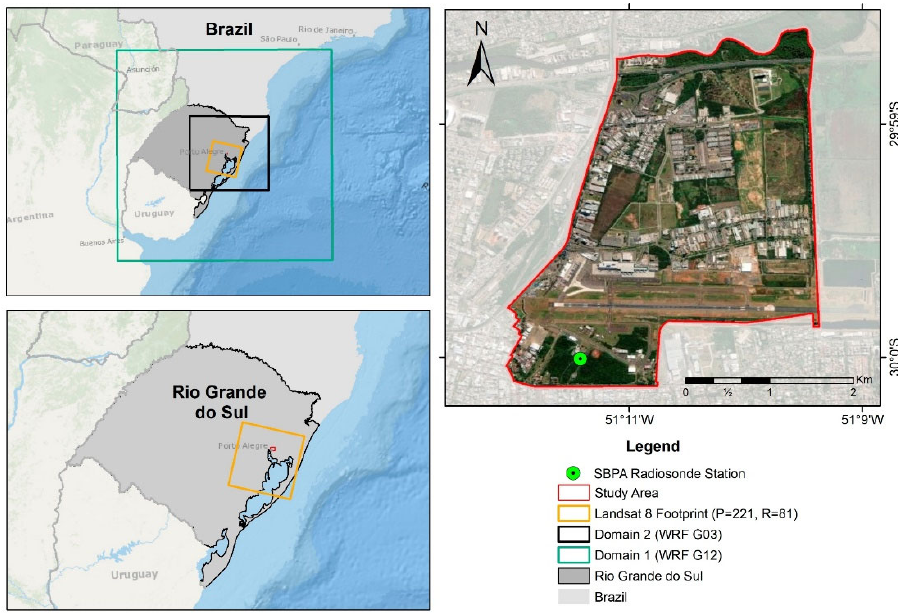
Figure 1. Map of the study area showing the Porto Alegre Airport (SBPA) radiosonde station, Southern Brazil, and the WRF nested grids.